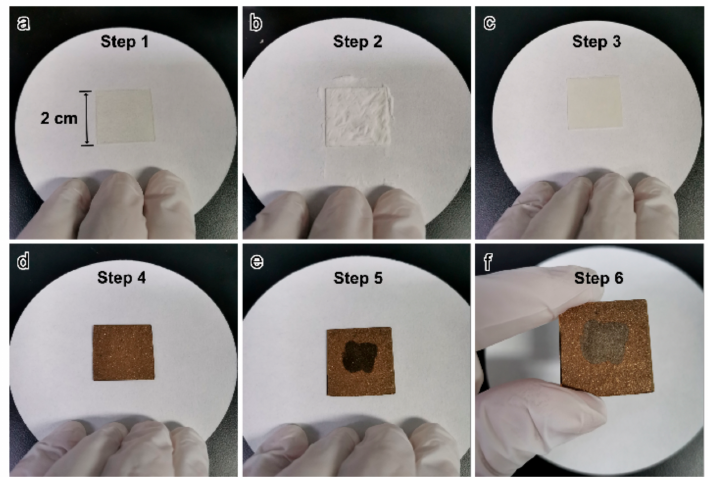
Figure 2. ( a ) A double sticky tape is pasted on a glass substrate. ( b , c ) Preparation of the SAP layer on the substrate. ( d ) Deposition of the Au thin film on the SAP layer. ( e , f ) Dropping deionized water onto the Au film to create the Au